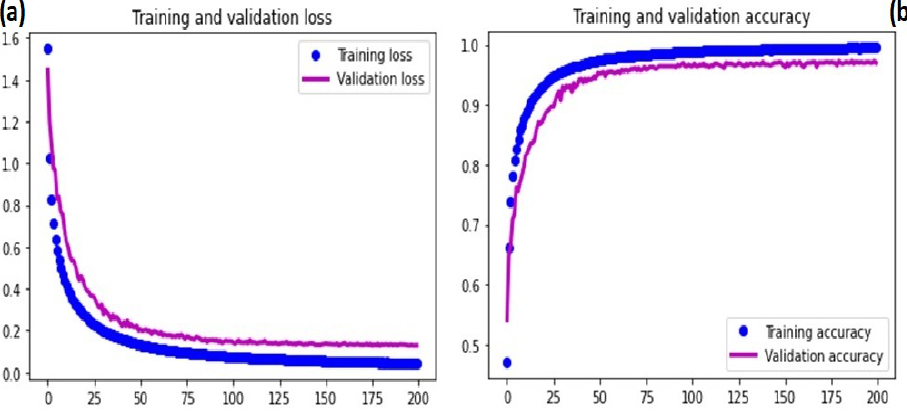
Figure 10. Stage II DCAE-CNN classification model convergence based on loss and accuracy: ( a ) training and validation loss; ( b ) training and validation accuracy. Table 1. The classification results of the Stage II DCAE-CNN. of the DCAE-CNN in Stage II. Precision Sensitivity Number of Images/Class